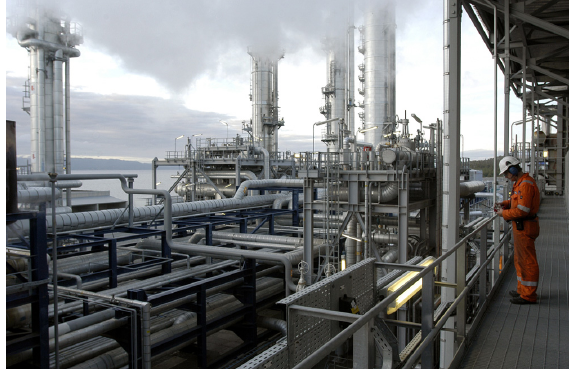
Figure 13: Statoil’s process plant at Tjeldbergodden depends on computer-based process control systems. Photo: Harald